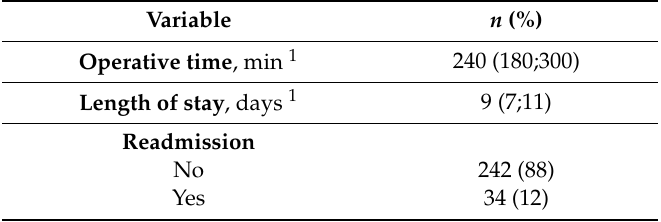
Table 1. Perioperative details of 276 patients submitted to surgery for pancreatic neuroendocrine neoplasms